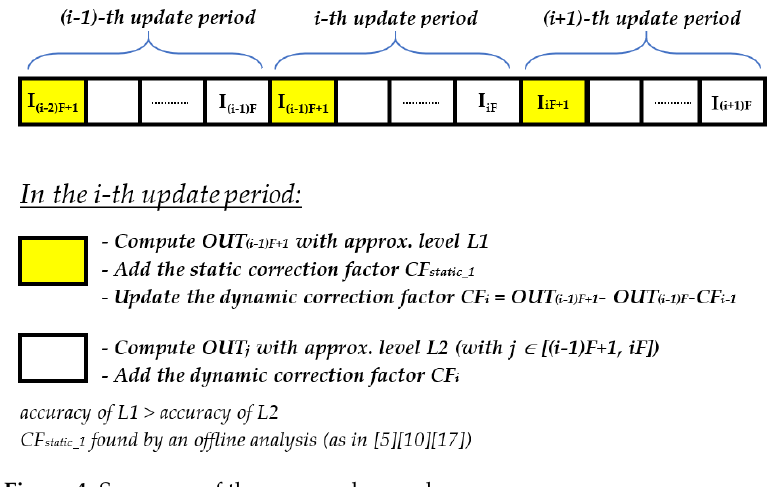
Figure 4. Summary of the proposed procedure.